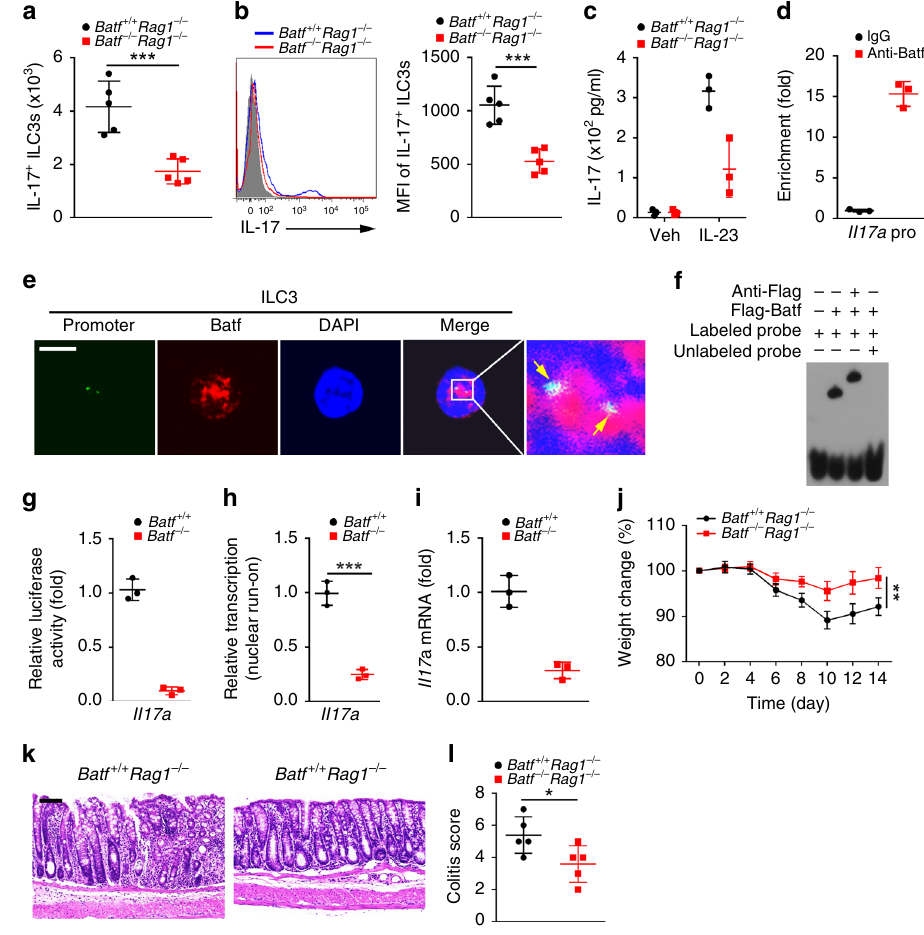
Fig. 6 Batf triggers ILC3 activation and colitis induction. a IL-17 + ILC3 numbers were analyzed in Batf + / + Rag1 − / − or Batf − / − Rag1 − / − mice after DSS treatment (*** P = 0.0009). n = 5 independent samples. b Expression of IL-17 was measured in Batf + / + Rag1 − / − or Batf − / − Rag1 − / − ILC3s from DSS-treated mice. Geometric MFI of IL-17 + ILC3s was presented in the right panel (*** P = 0.0005). n = 5 independent samples. c ELISA assay using Batf + / + Rag1 − / − or Batf − / − Rag1 − / − ILC3s from DSS-treated mice. Veh vehicle. n = 3 independent samples. d Analysis of Batf enrichment on Il17a promoter in ILC3s by ChIP assay. n = 3 independent samples. e Co-localization between Batf and Il17a promoter was analyzed by FISH in ILC3s isolated from DSS-treated WT mice. Green, Il17a promoter; red, Batf; blue, nucleus. Scale bar, 5 μ m. f The interaction between Batf and Il17a promoter was tested by EMSA assay. g Luciferase reporter assay was performed using Il17a reporter in Batf + / + and Batf − / − ILC3s. n = 3 independent samples. h Batf + / + and Batf − / − ILC3s were subjected to nuclear run-on assay, followed by RT-PCR analysis of Il17a (*** P = 0.0004). n = 3 independent samples. i Relative expression of Il17a in ILC3s isolated from Batf + / + and Batf − / − mice treated with DSS. n = 3 independent samples. j Analysis of body weight changes of indicated mice after DSS treatment (*** P = 0.0017). n = 5 for each group. k H&E staining of colons from indicated mice treated with DSS. Scale bar, 100 μ m. l Colitis scores of indicated mice as in k (*** P = 0.0372). n = 5 independent samples. * P <0.05, ** P <0.01, and *** P <0.001. Data were analyzed by an unpaired Student ’ s t -test and shown as means ±SD. Data are representative of at least three independent experiments. Source data are provided as a Source Data fi (Fig. 7f, g), indicating that IL-17 induced by ILC3s plays a critical role in circKcnt2 -mediated in fl ammatory inhibition. Taken together, circKcnt2 recruits the NuRD complex onto Batf promoter to suppress its expression, which inhibits ILC3 activation to facilitate innate colitis resolution.